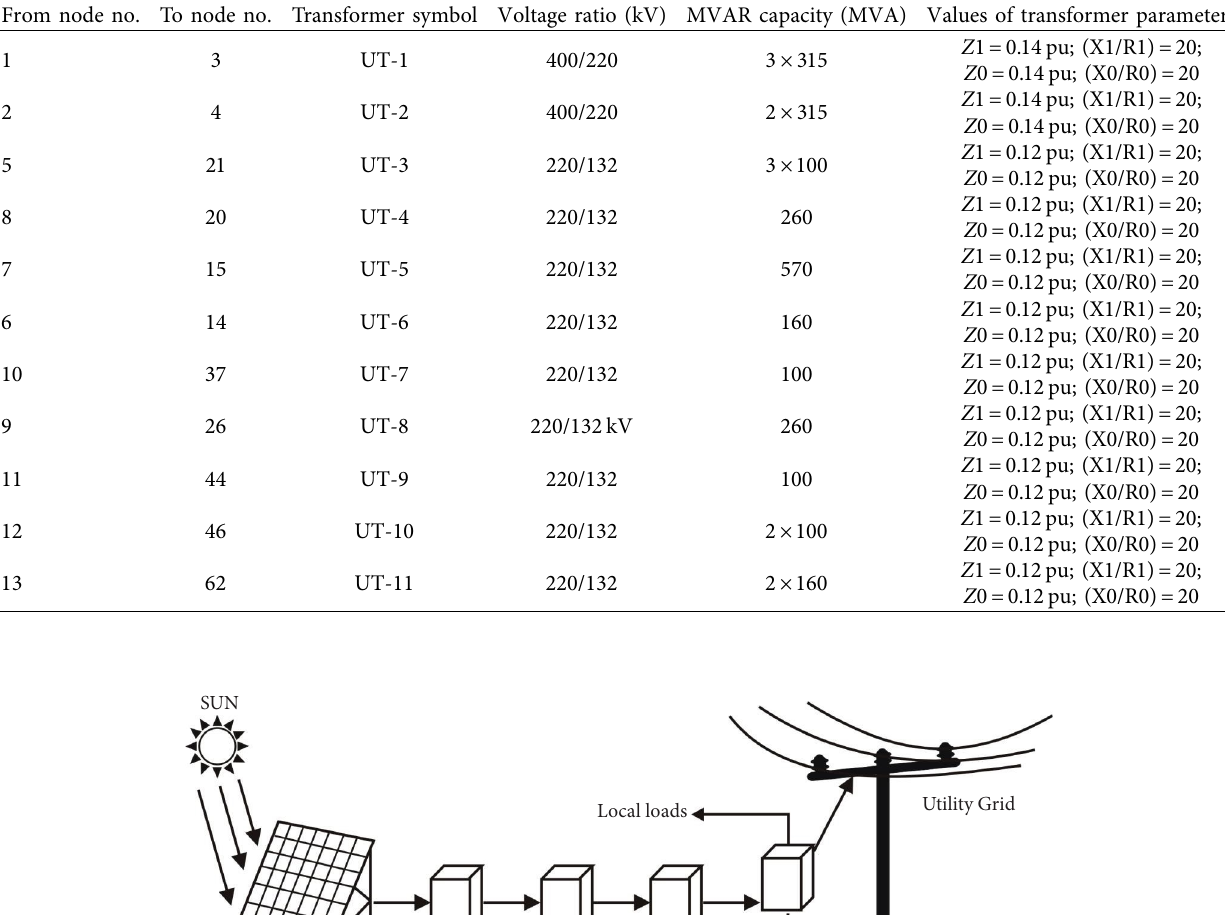
Table 7: Description of transformers.